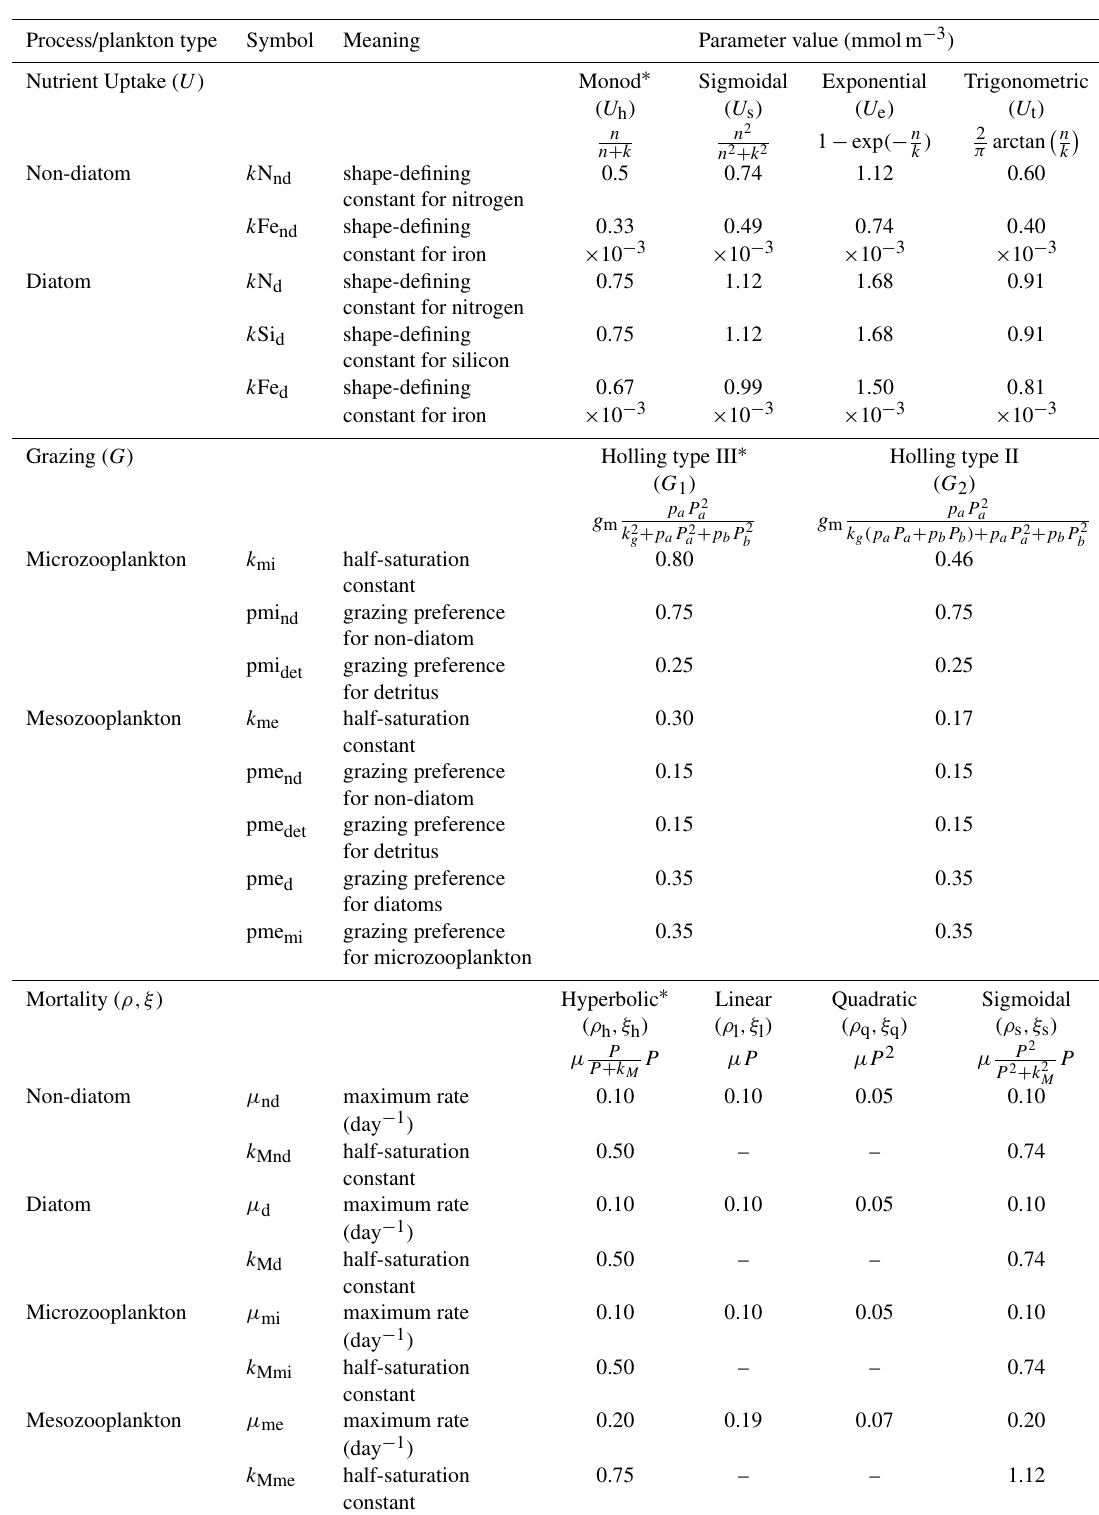
Table 1. Parameter values for resource uptake ( U ), zooplankton grazing ( G ), and plankton mortalities ( ρ and ξ for phytoplankton and zooplankton respectively), described using similar functional forms (shown in Fig. 1). In the grazing equation, g m represents the maximum grazing rate, P a is the prey, and p a denotes the grazing preference. Starred equations are the default functional responses in